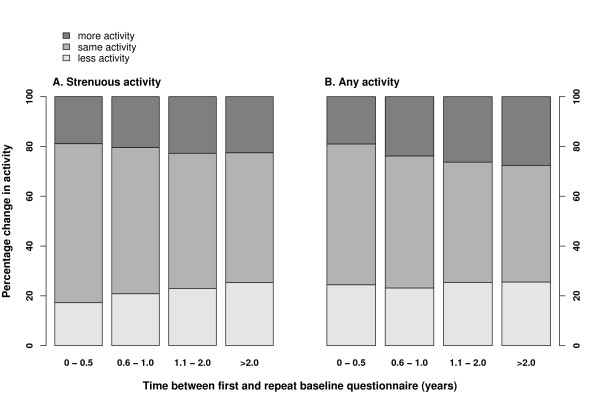
Distributions of changes in reported physical activity by time between first and repeat baseline questionnaires. Shaded regions indicate proportions of women reporting a frequency of physical activity on their repeat baseline questionnaire that was the same as, more than, or less than they reported at first administration. Women are stratified by the time between their first and repeat responses to the baseline questionnaire.